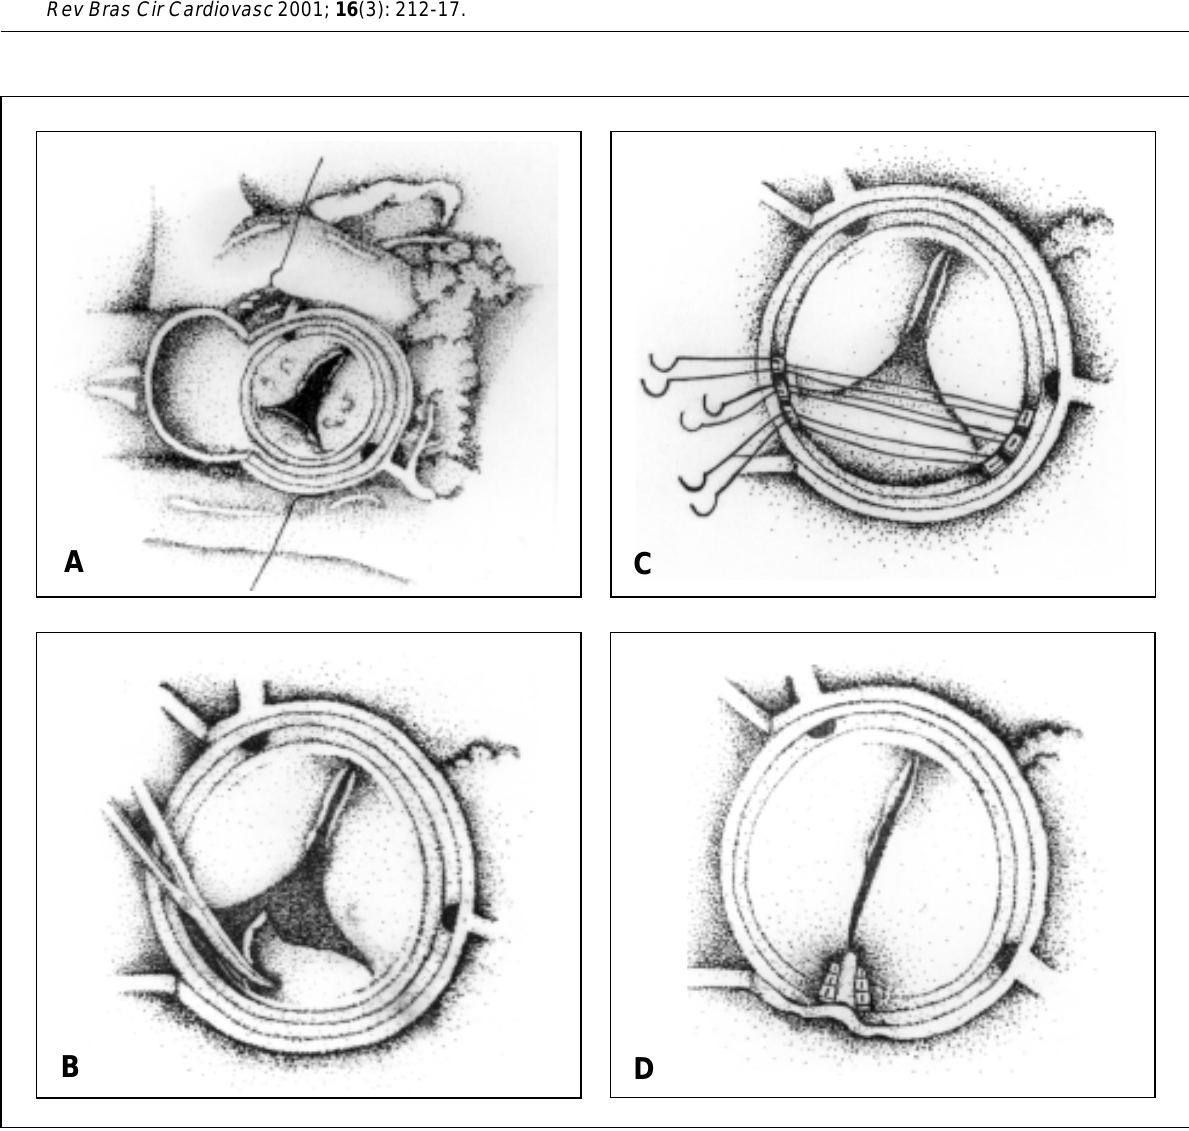
Fig. 1 – A. Desenho que representa a valva aórtica competente; B. Ressecção da válvula aórtica não coronariana; C. Pontos ancorados em feltro de teflon são passados junto às comissuras correspondentes à válvula ressecada. D. Observa-se no aspecto final do esquema da operação, a valva aórtica